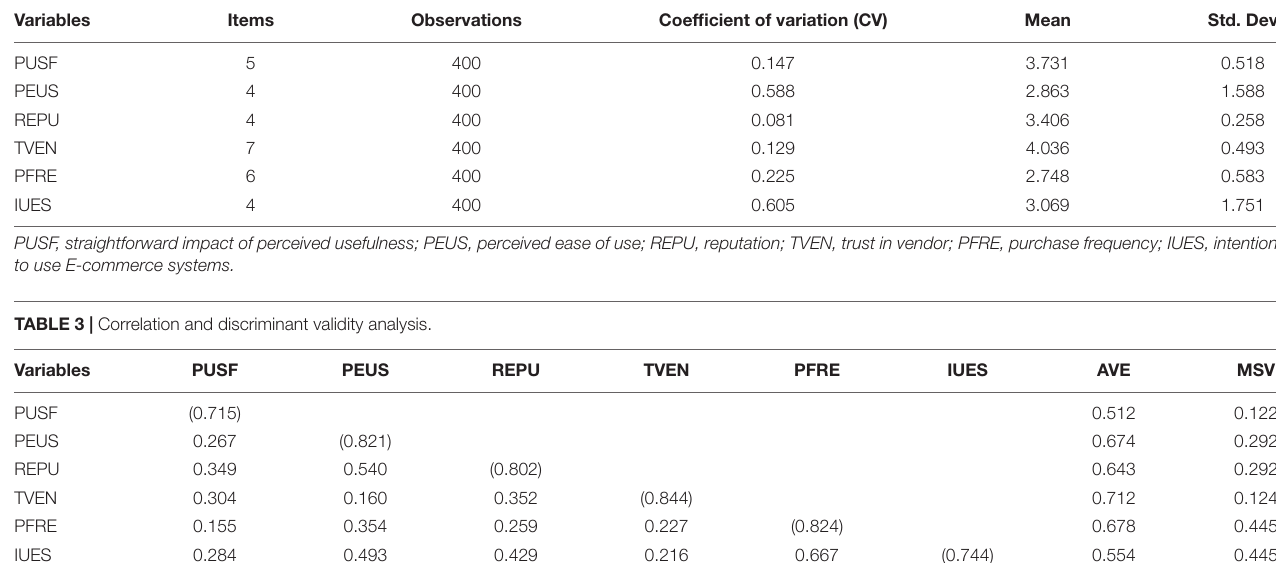
TABLE 2 | Results of descriptive statistics.